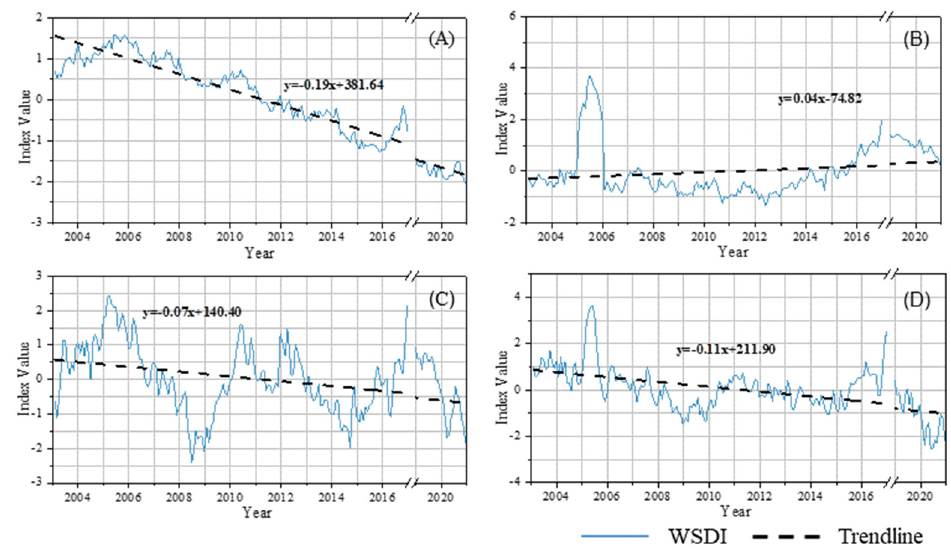
Figure 5. WSDI time series and fitting trends in the arid regions of central Asia near the ( A ) Caspian Sea, ( B ) Kazakh Hills, ( C ) Moynkum Desert, and ( D ) Gurbantünggüt Desert.